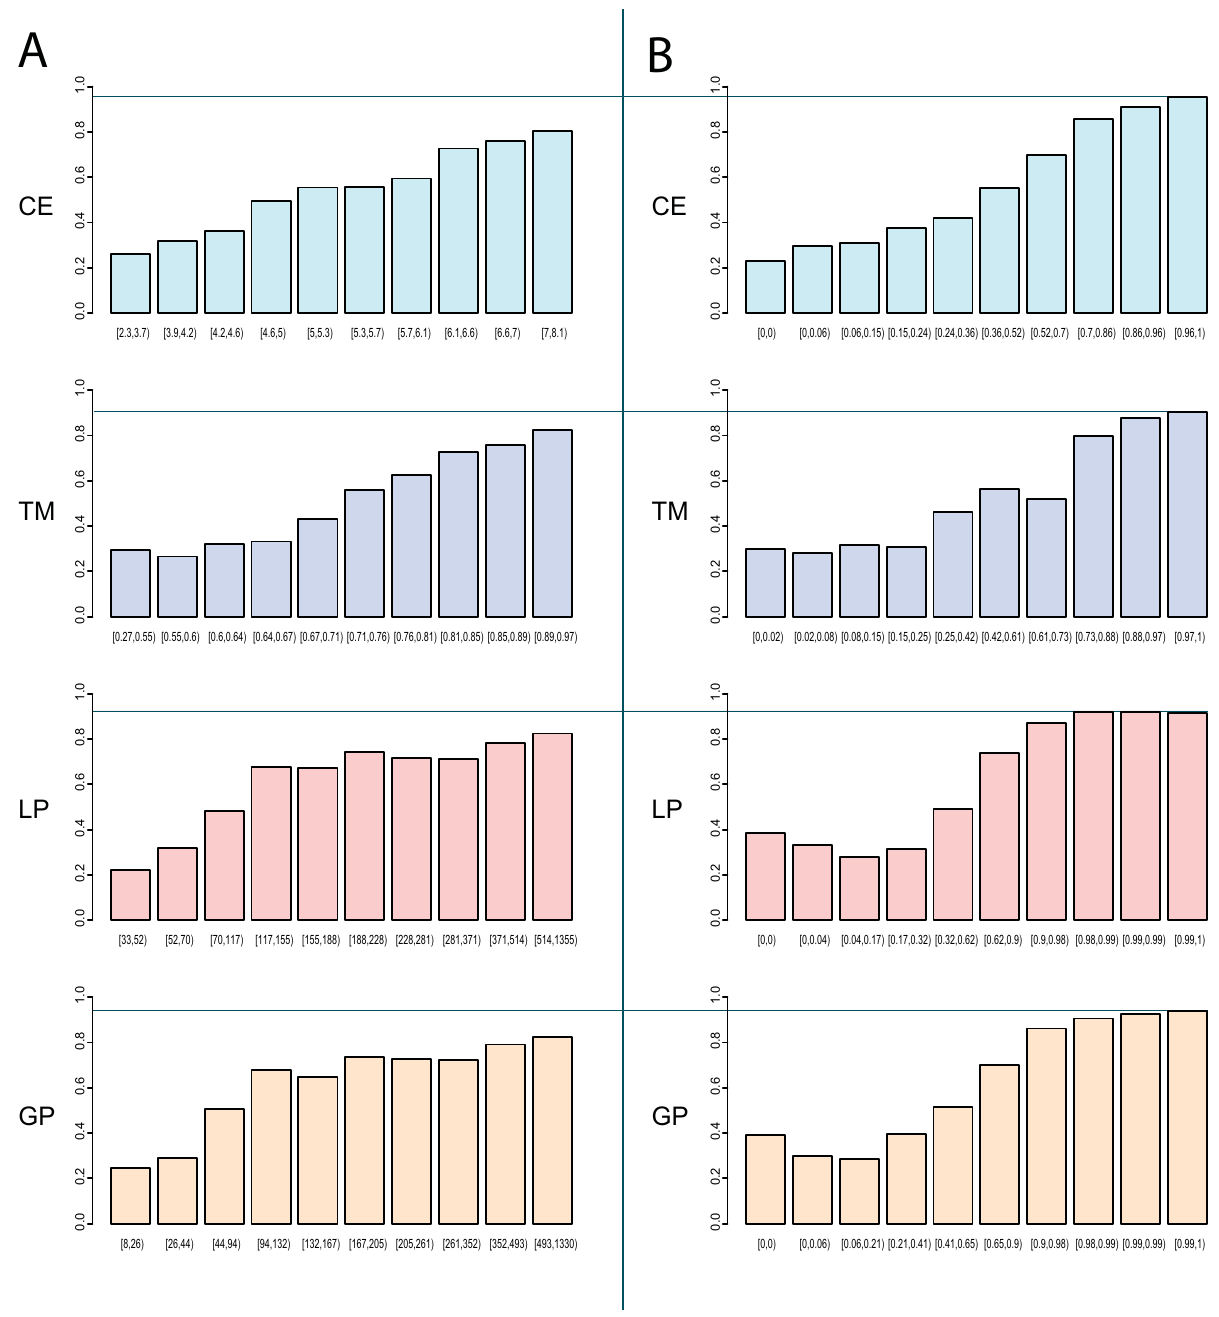
Figure 1. Assessing Similarity-Based Inference. (A) The plot serves to assess the errors made when inferring GO terms from the nearest neighbor of each protein. The inferred annotations are sorted according to the similarity measures (CE, TM, LP, GP) and then binned such that each bin contains an equal number of annotation counts (ca. 670 annotations). This allows for comparing the number of errors for the inference according to different similarity measures which are operating on different scales. The x-axis denotes the range of similarity measure scores falling into that bin, the y-axis the ratio of correct annotations in that range. (B) In contrast to (A), the inferred annotations are sorted according to raw function conservation scores, based on the similarity measures (CE, TM, LP, GP). The x-axis denotes the range of raw function conservation scores falling into that bin, the y-axis the ratio of correct annotations in that range. doi:10.1371/journal.pcbi.1000105.g001 the type of molecular function, the number of protein domains nearest neighbor proteins and using logistic regression, we obtain having that function, and the metric used to calculate protein one logistic curve for each GO term, capturing the extent of similarity. Therefore, we estimate the degree of function functional conservation in the region around the protein domain. conservation separately for each GO molecular function in the The logistic regression is done separately for each similarity region around each protein domain. Analyzing the region of 200 measure.